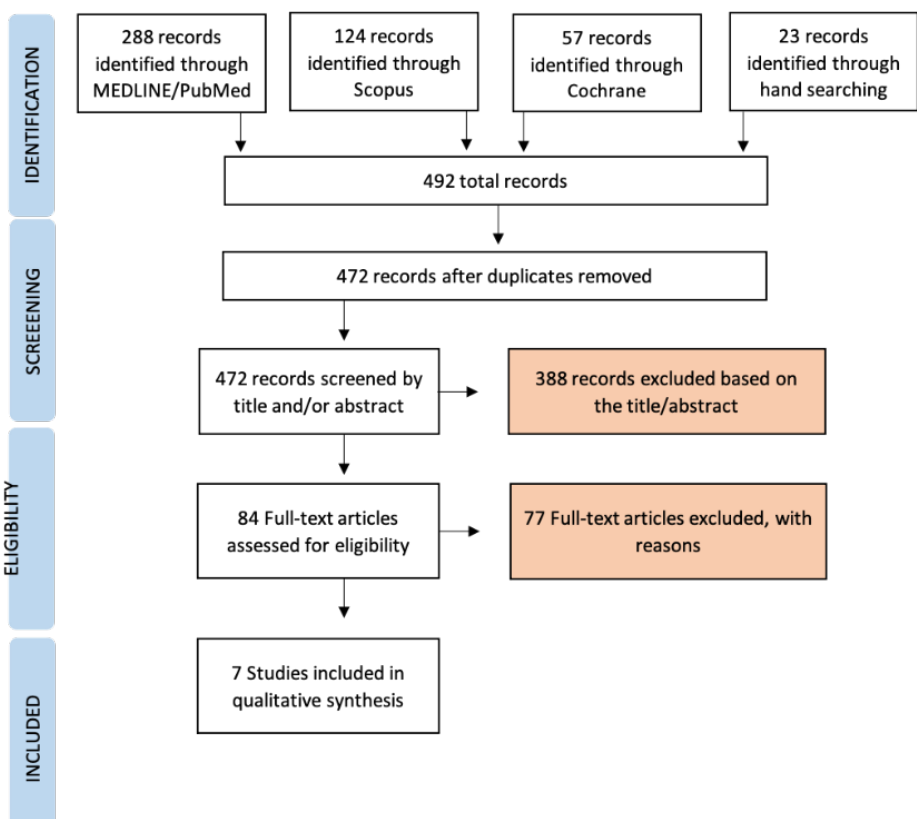
Figure 1. PRISMA flow chart of articles screened, withdrawn, and included in the review process.